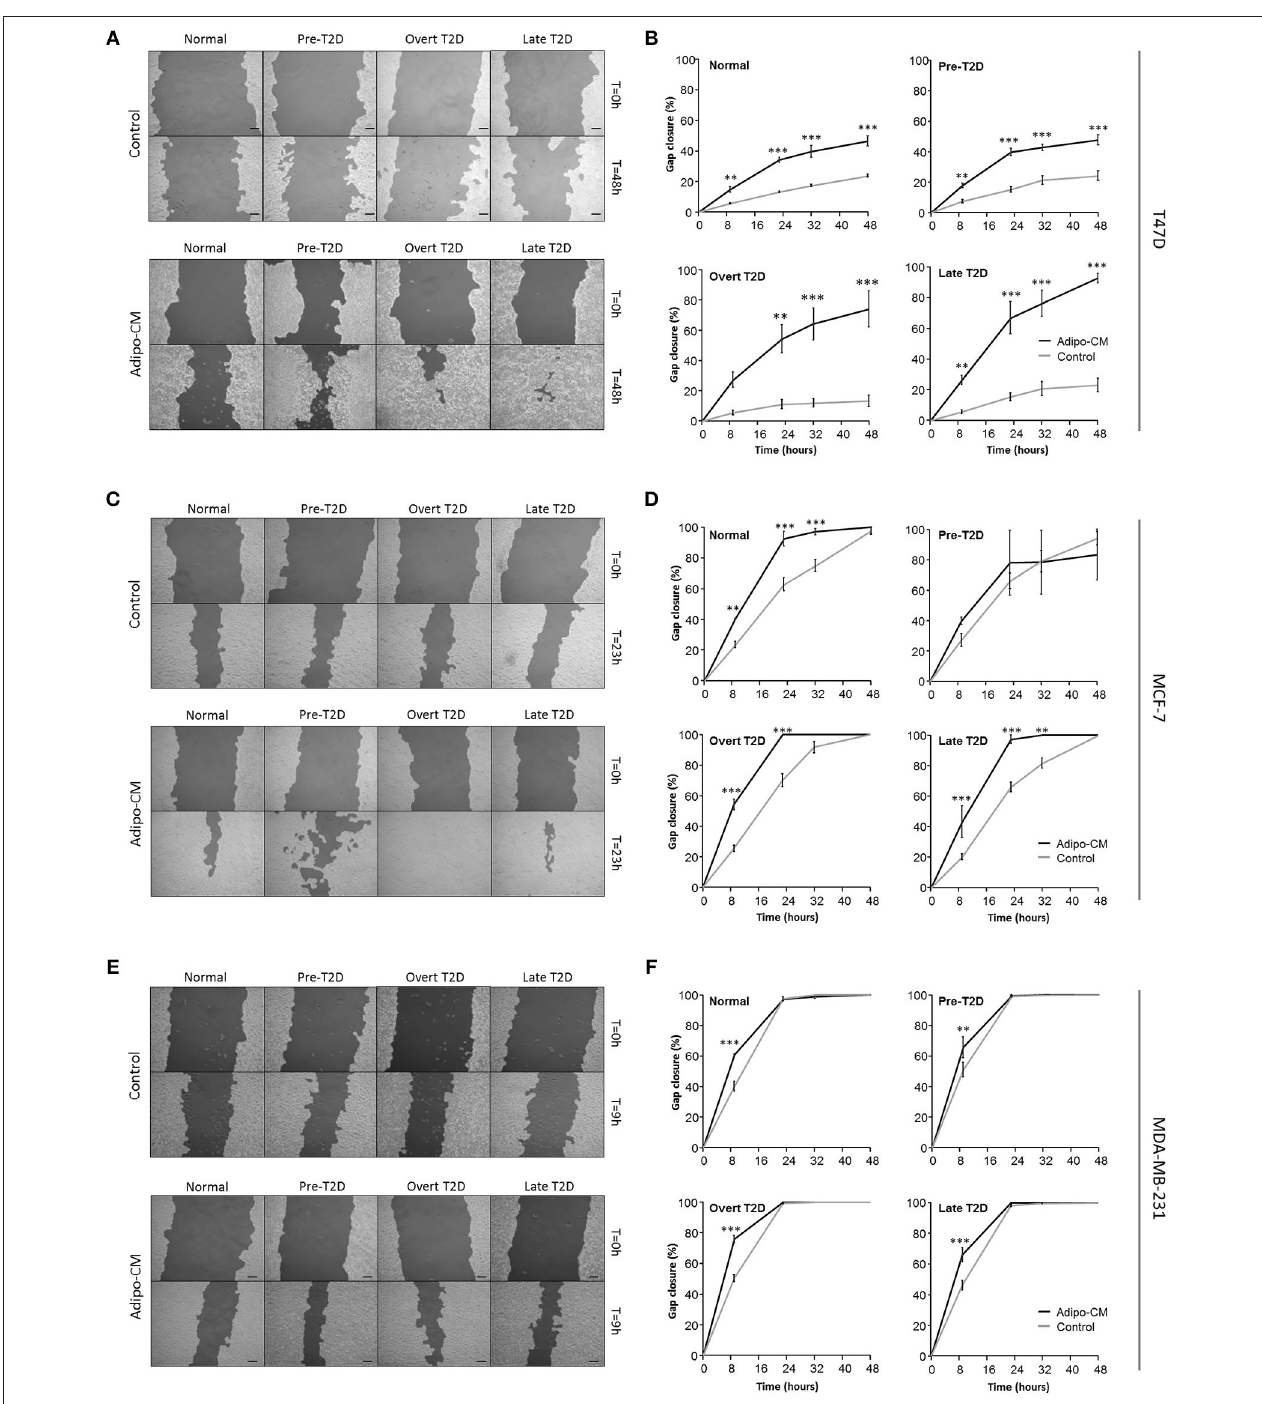
FIGURE 3 | Adipocyte-derived mediators stimulate cell migration. Effects by adipocyte-derived factors and obesity-associated metabolic conditions on breast cancer cell migration were analyzed by scratch assay and automated quantification. (A,C , E) Representative images of cell migration in control or adipo-CM at the indicated time points for (A) T47D, (C) MCF-7, and (E) MDA-MB-231 cells. The lighter gray area show cell monolayers, and darker area show open scratch. Scale bar: 100 µ m. (B , D , F) Graphs show quantification of percent gap closure as a measure of migration over time compared with time 0 for (B) T47D, (D) MCF-7, and (F) MDA-MB-231 breast cancer cells exposed to adipo-CM or control and the indicated metabolic conditions. Results are presented as mean ± SE ( n = 3–4) from one representative of three experiment. Statistical analysis was performed by two-way ANOVA with Bonferroni correction; significant differences between cells exposed to adipo-CM and control shown as ** P < 0.01 and *** P <